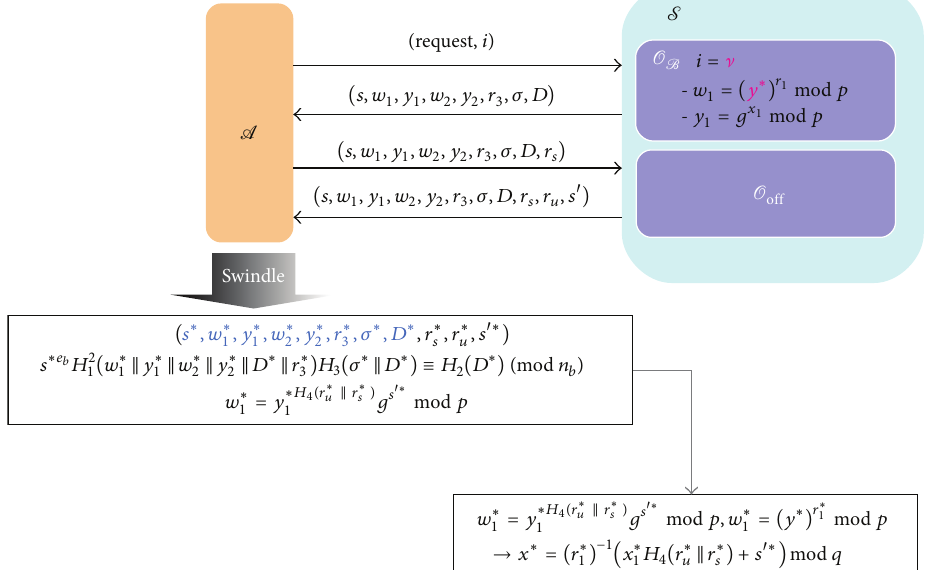
Figure 9: The proof model of